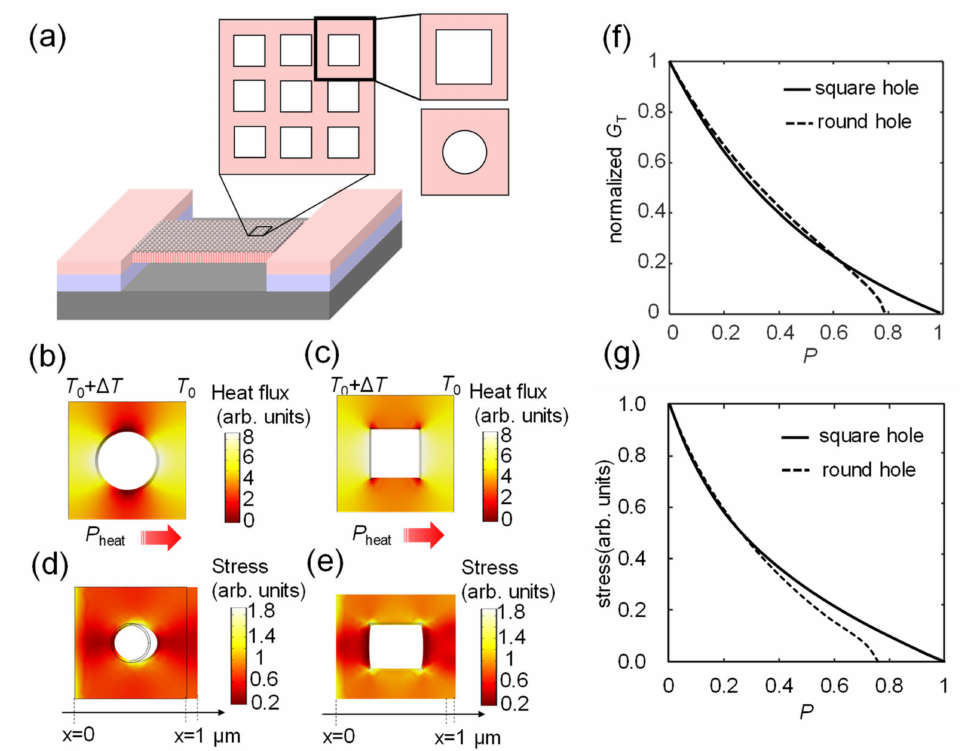
Figure 1. ( a ) The basic unit of a porous MEMS resonator. The holes were designed by using a round hole array and a nanomesh structure. ( b ) The calculated distribution of heat flow of the round hole structure, obtained by assuming a fixed temperature difference ∆ T = 1 K between the left and right edges of the round hole unit. ( c ) The calculated distribution of heat flow of the square hole structure. ( d ) The calculated stress distribution of the round hole structure, obtained by assuming a fixed stress in the lateral direction of the unit. ( e ) The calculated stress distribution of the square hole structure. ( f ) The calculated thermal conductance as a function of P of the nanostructures. The solid line represents the thermal conductance of the round hole structure, and the dotted line represents that of the square hole structure. ( g ) The calculated tensile strength as a function of P of the structure. The solid and the dotted lines represent the tensile strengths of the square and round hole structures,